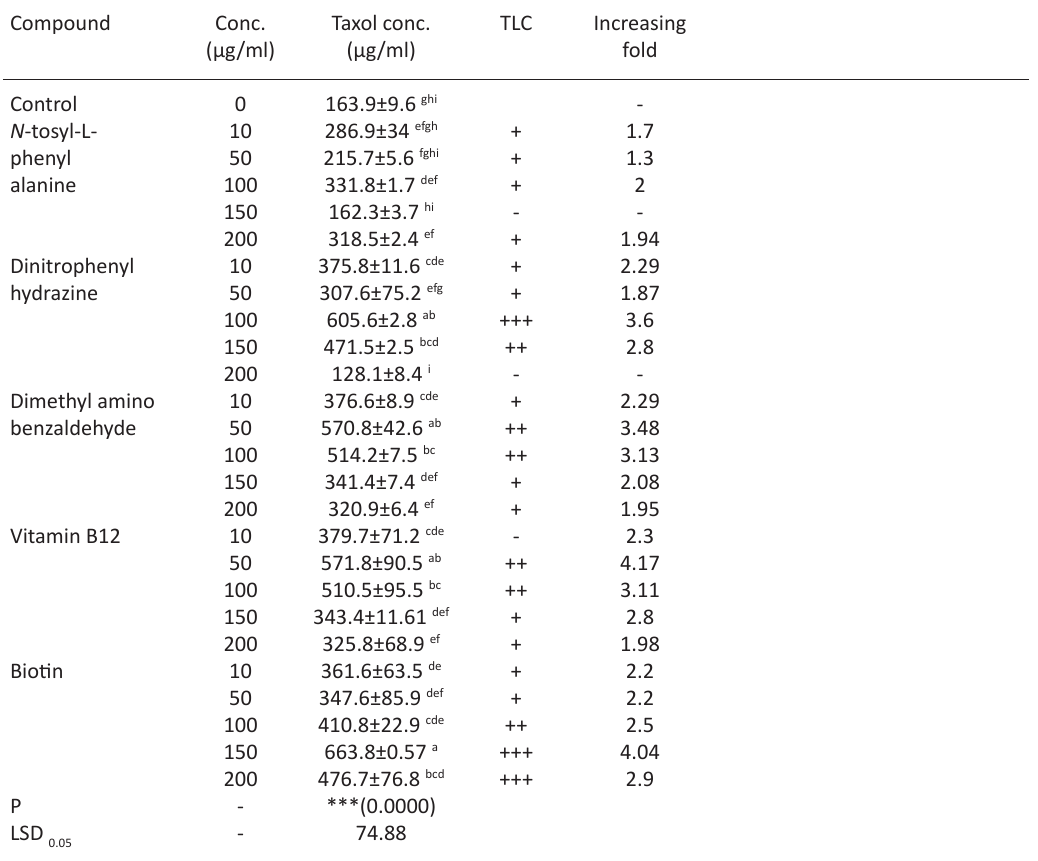
-values given are means - The mean values followed by different letters a, b, c with in the same column are significantly different (ONE Way ANOVA, Tukey HSD test, p ≤ 0.05). *** means highly significant . -LSD: the least significant